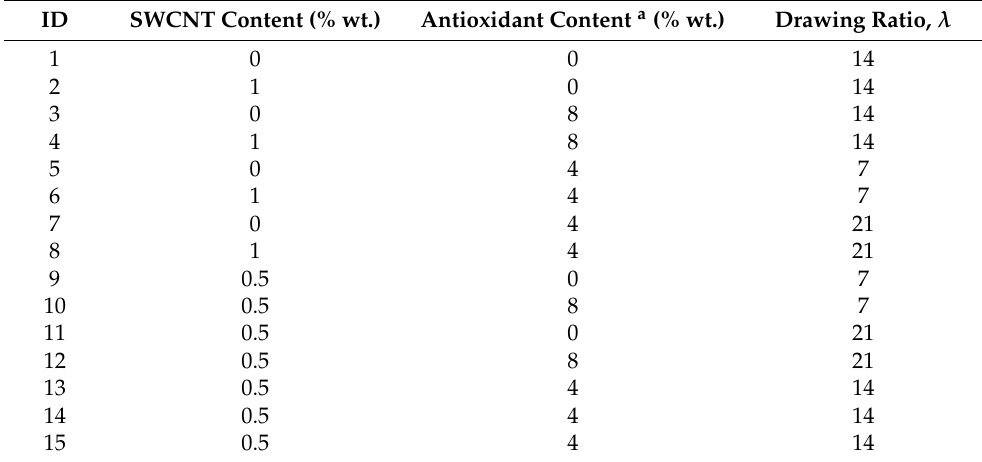
Table 3. Compositions and drawing ratios for the 15 experiments of the second DoE (composites with SWCNTs). ID SWCNT Content (%